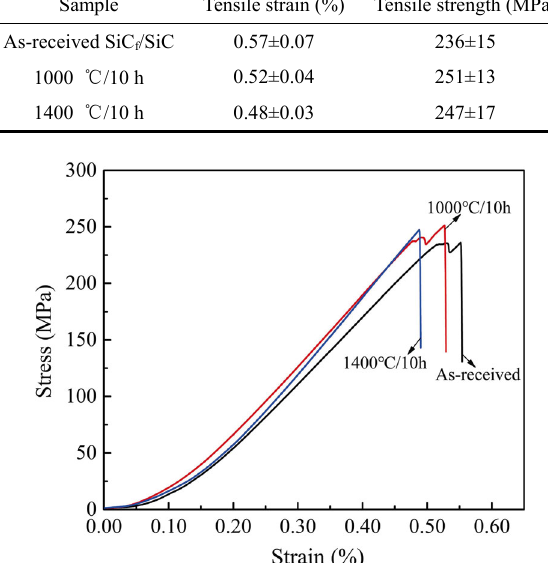
Fig. 7 Tensile stress–strain curves of as-received and heat-treated SiC f /SiC composites.